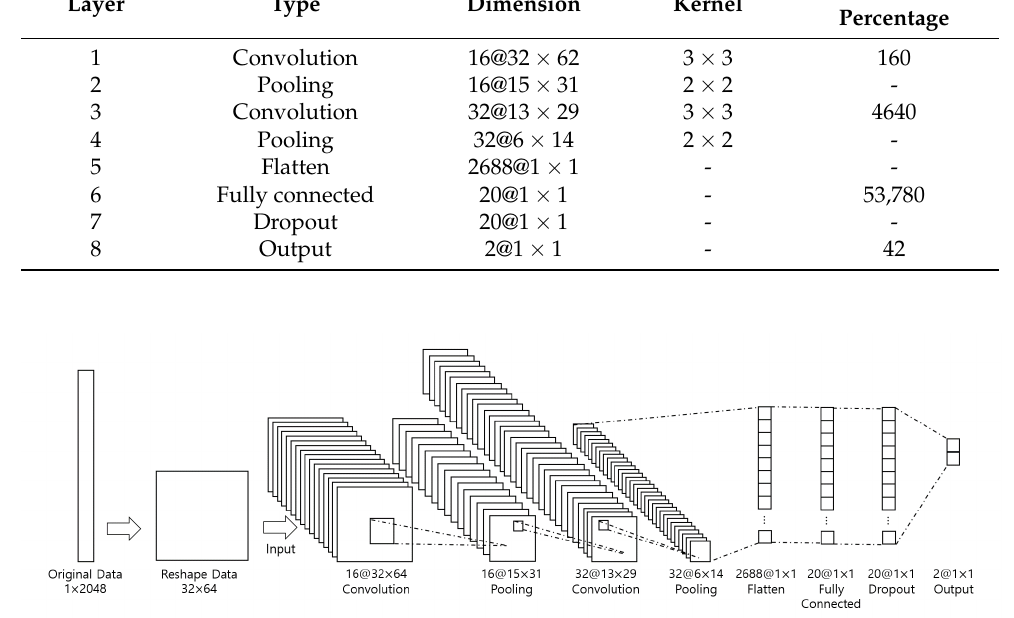
Figure 2. CNN Structure employed in the